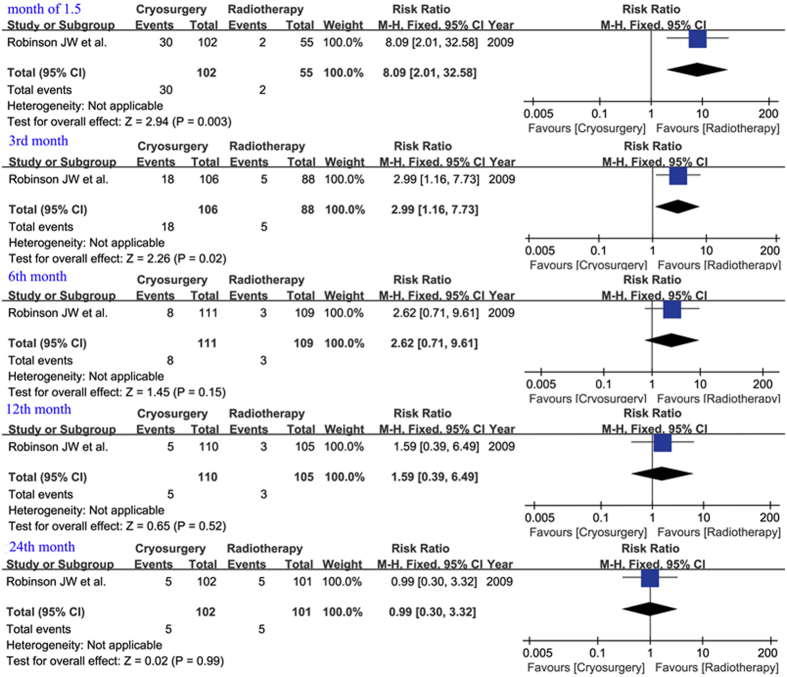
Dynamical forest plot and meta-analysis of patients reporting a moderate or severe problem of urinary bother in comparisons of CS vs RT in months of 1.5, 3, 6, 12 and 24, respectively.